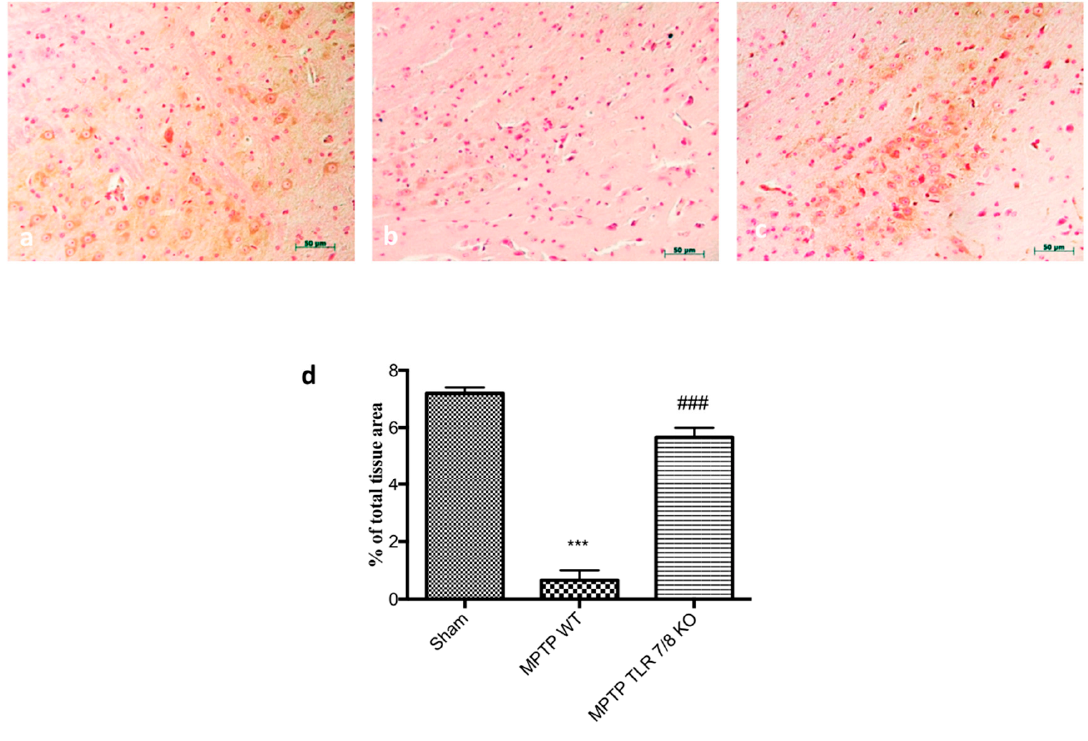
Figure 6. Effect of TLR7/8 on DAT expression in SN of MPTP-treated mice. Immunohistochemical analysis of midbrain obtained from WT mice after MPTP intoxication revealed an important loss of DAT-positive cells ( b ; see densitometric analysis d ) compared to WT ( a , see densitometric analysis d ); while the absence of TLR7/8 preserved the reductions of DAT ( c ; see densitometric analysis d ). Data are means ± SEM of 10 mice for each group. *** p < 0.001 vs. SHAM WT; ### p < 0.001 vs. MPTP WT.